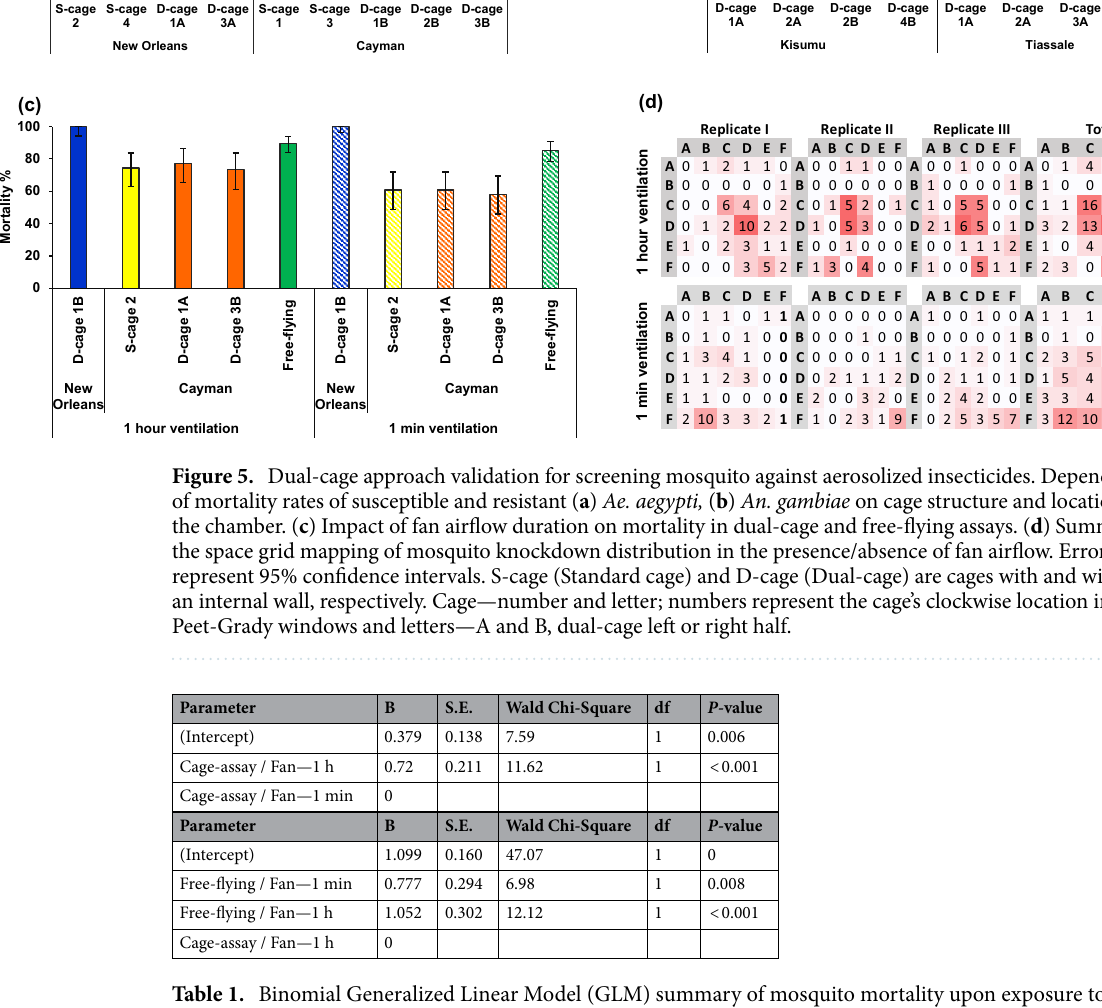
Table 1. Binomial Generalized Linear Model (GLM) summary of mosquito mortality upon exposure to aerosolized insecticides in relation to bioassay set-up (cage-based or free-flying mosquitoes) and airflow ventilation